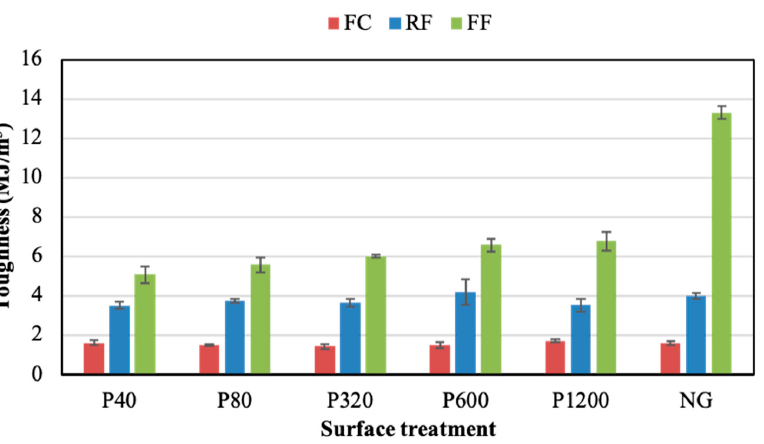
Figure 7. Ductility of adhesive joints under different surface treatments without adhesion promoter.